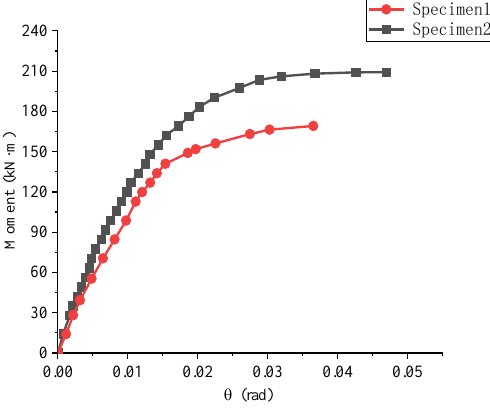
Figure 17. Moment–rotation curve.